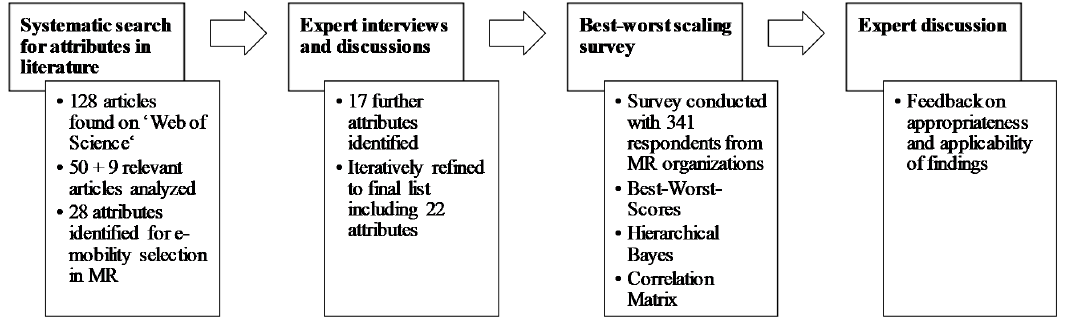
Figure 1. Process map of the applied multi ‐ method research approach.